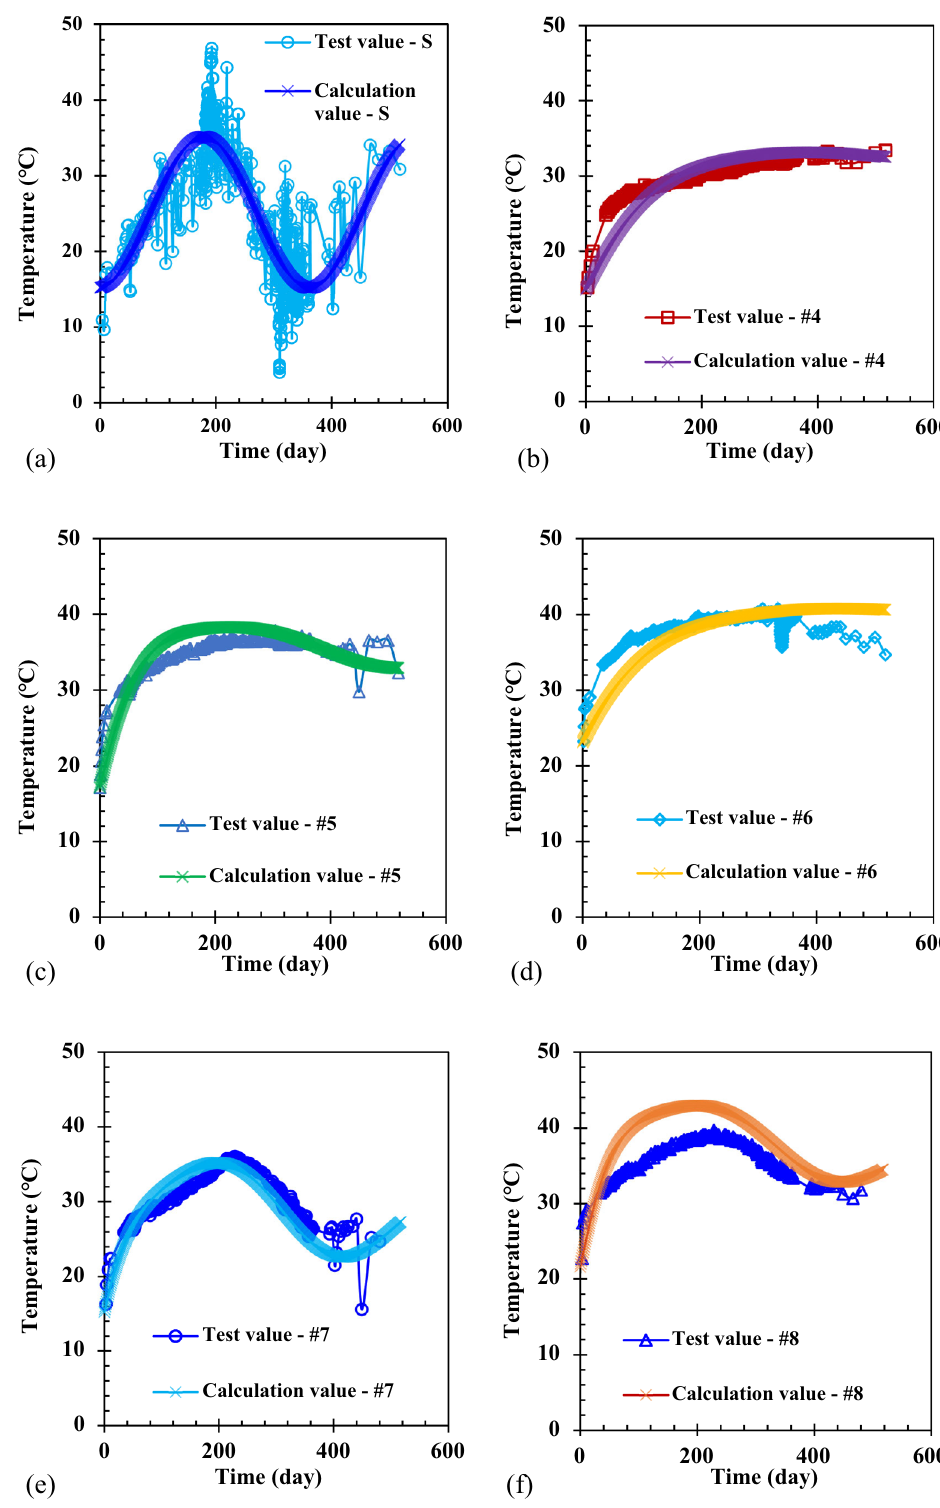
Figure 2. Comparison of the calculation and test values of temperature with time at the bottom of the different wells: ( a ) Surface (Depth: 0 m); ( b ) #4 well (Depth: 5.88 m); ( c ) #5 well (Depth: 3.58 m); ( d ) #6 well